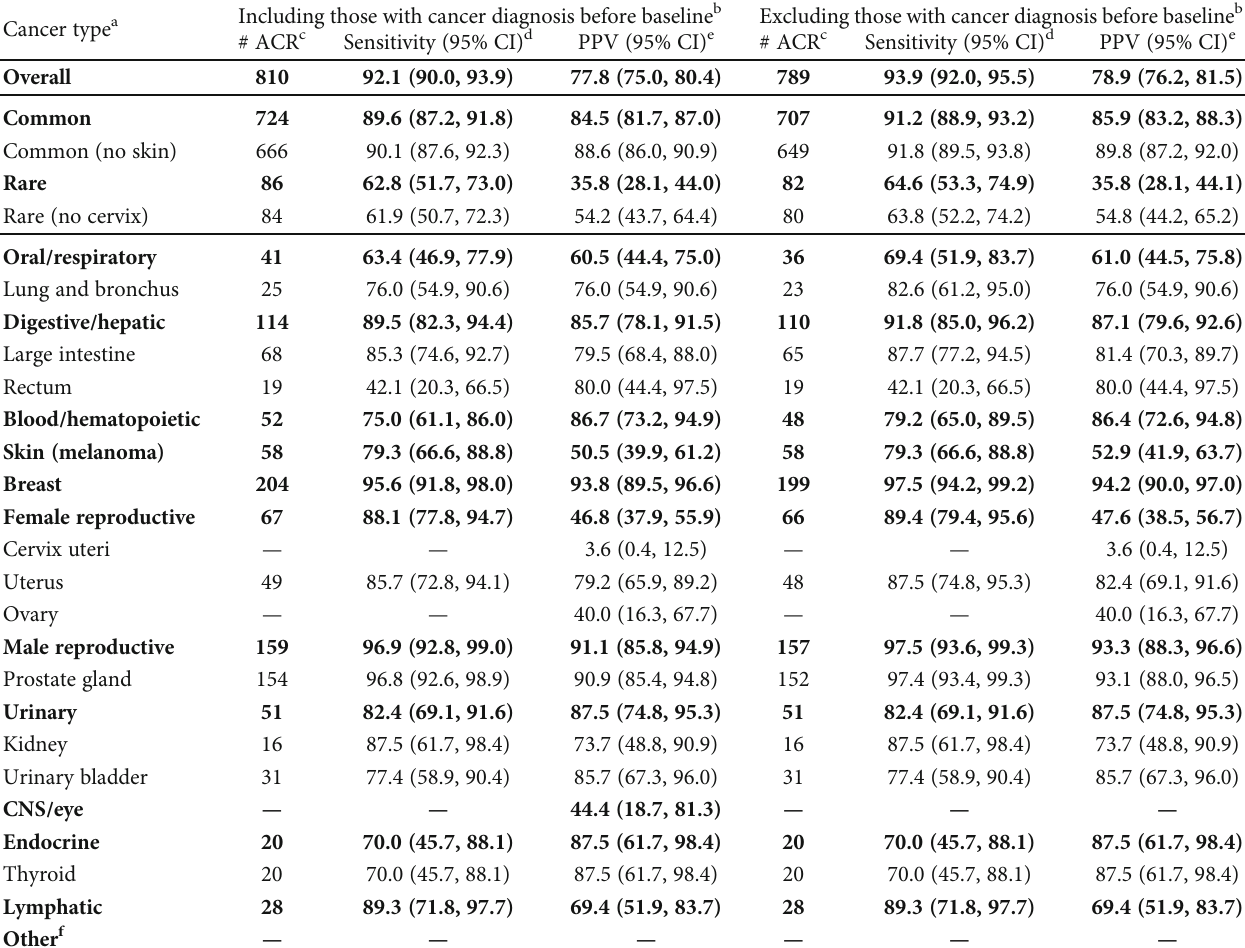
Table 2: Sensitivity and positive predictive value (PPV) of self-reported cancer